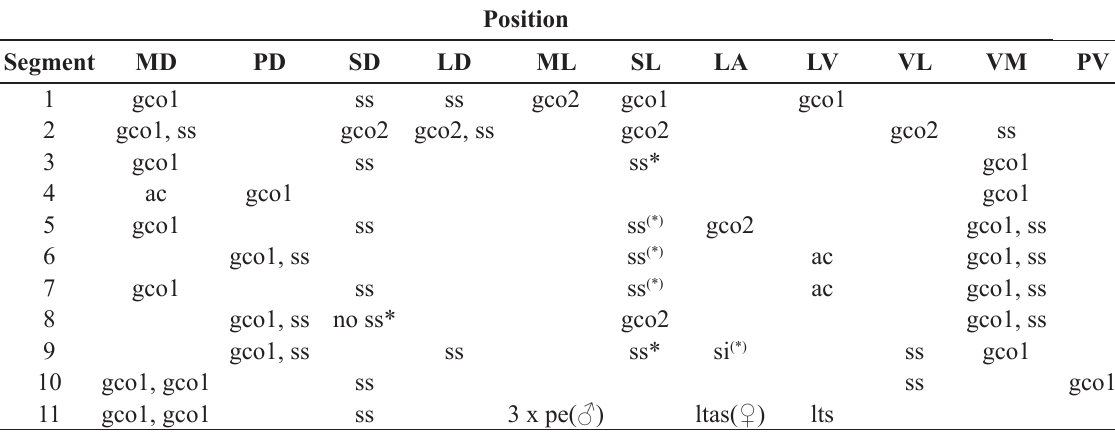
Table 17. Summary of nature and location of sensory spots, glandular cell outlets, tubes and spines arranged by series in Echinoderes cf. unispinosus . Abbreviations: LA = lateral accessory; LD = laterodorsal; LV = lateroventral; MD = middorsal; ML = midlateral; PD = paradorsal; PV = paraventral; SD = subdorsal; SL = sublateral; VL = ventrolateral; VM = ventromedial; ac = acicular spine; gco1/2 = glandular cell outlet type 1/2; ltas = lateral terminal accessory spine; lts = lateral terminal spine; pe = penile spines; si = sieve plate; ss = sensory spot; ( ♀) = female and ( ♂ ) = male conditions of sexually dimorphic characters; * = marks characters differing in presence/absence from the original species description of Yamasaki et al . (2018b); (*) = marks characters also present in the original species description of Yamasaki et al . (2018b), but in a slightly different